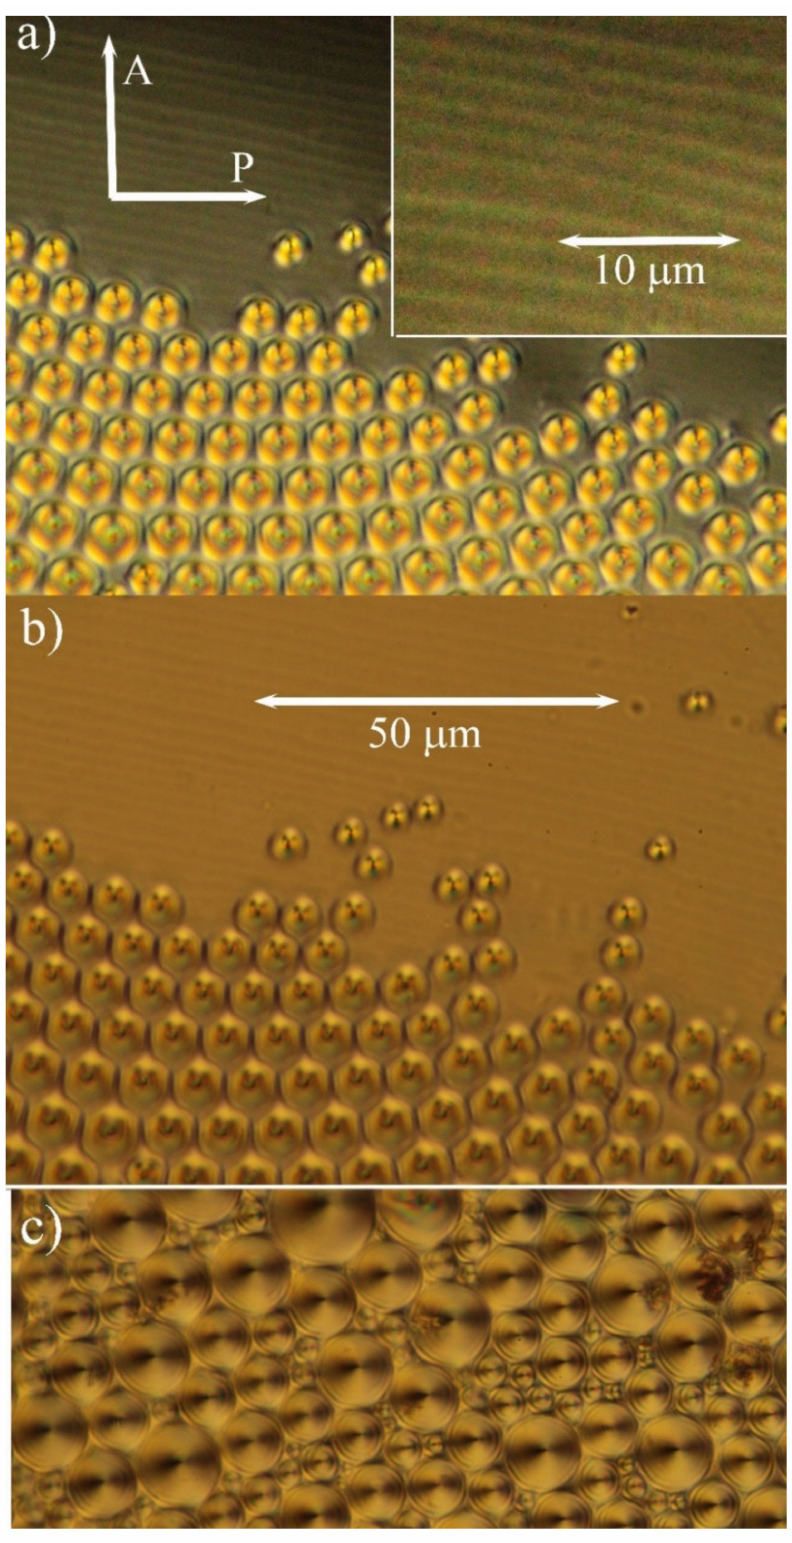
Figure 4. Microphotographs of a droplet on a glass plate: ( a ) under crossed polarisers and ( b ) the identical part of the sample in depolarised view with a common scale bar for all three figures. The inset in ( a ) shows the border of the droplet in an enlarged view and ( c ) presents focal conics in the thicker part of the